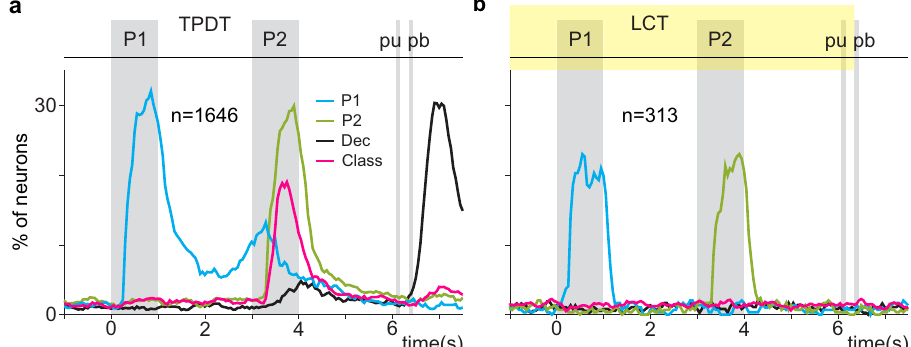
Fig. 3 S2 Population coding dynamics during the TPDT and LCT. a – b Percentage of neurons with signi fi cant coding (see Supplementary Fig. 3) as a function of time during the TPDT ( n = 1646) and the LCT ( n = 313). Traces refer to P1 (cyan), P2 (green), all class coding (pink), and decision coding (black). Note that P1 working memory, decision, and class coding essentially vanished during the LCT: instead, the coding was restricted to stimulus periods in the LCT. Similar to frontal lobe areas, all categorical and perceptual codes are abolished during the control, but akin to S1, S2 sensory responses always persist (see Supplementary Fig.